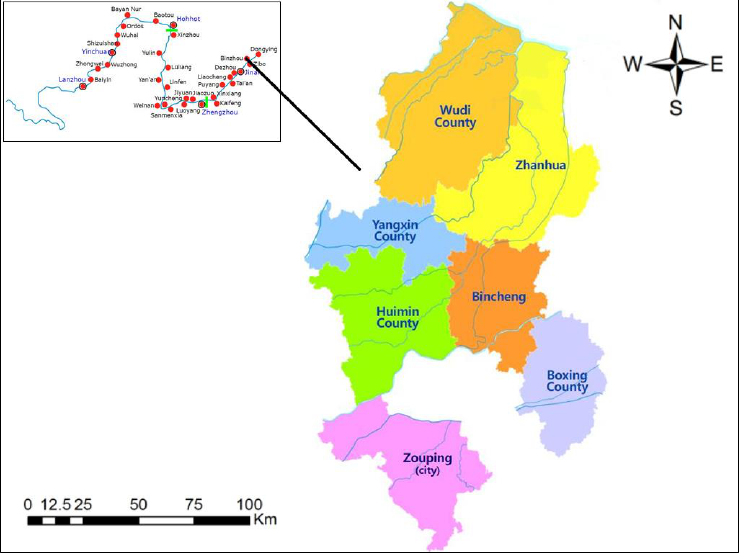
Figure 1. Map showing the location of Binzhou.